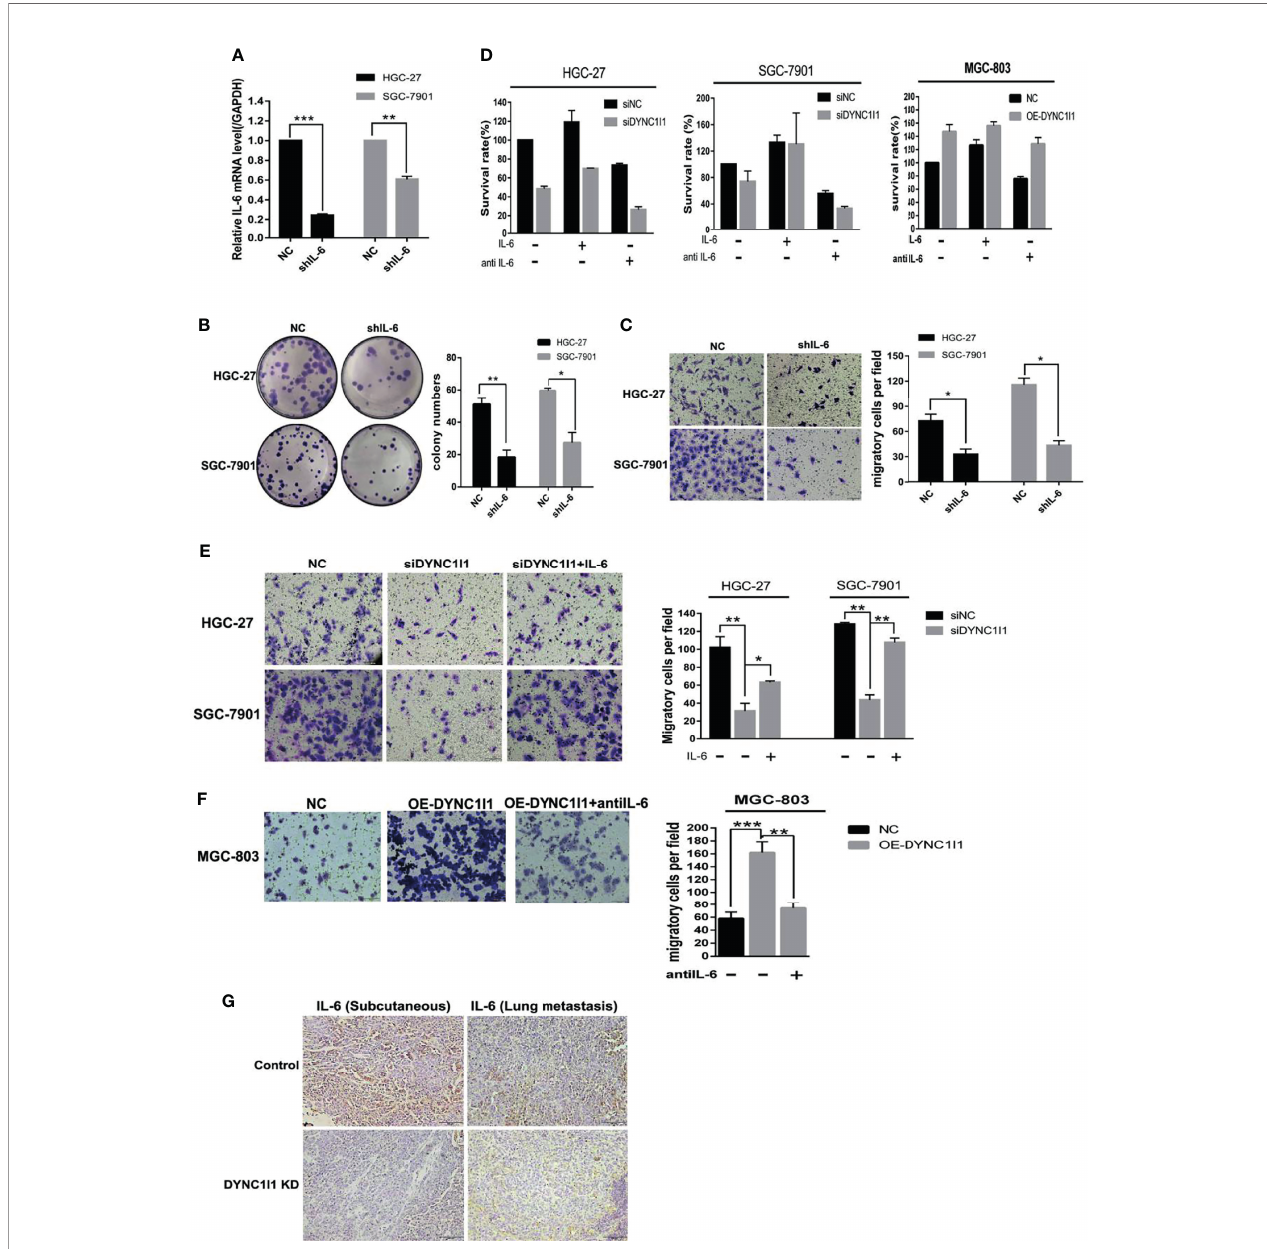
FIGURE 6 | DYNC1I1 promotes proliferation and migration of gastric cancer cells through IL-6. (A) RT-qPCR shows IL-6 transcription levels after knockdown IL-6 gene by using shRNA for 48 h. (B) Colony formation shows gastric cancer cells form colony ability after knocking down IL-6. (C) Transwell assays displays the change in migration of gastric cancer cells after knocking down IL-6 or not. (D) MTT shows proliferation ability of gastric cancer cells after adding IL-6 or IL-6 neutralizing antibody after knocking down or overexpression DYNC1I1. Add IL-6 or IL-6 neutralizing antibody 48 h after knocking down DYNC1I1. (E) Transwell assays shows the change in migration of gastric cancer cells after adding IL-6 after knocking down DYNC1I1. (F) Transwell assays shows the change in migration of gastric cancer cells after adding IL-6 neutralizing antibodies after overexpression DYNC1I1. (magni fi cation ×200) (G) Immunohistochemical detection of IL-6 expression in subcutaneous and lung metastatic tumors of mice tumor tissue(magni fi cation × 100). (* P < 0.05, ** P < 0.01, *** P < 0.001, n = 3, student t -test, means ± 95%